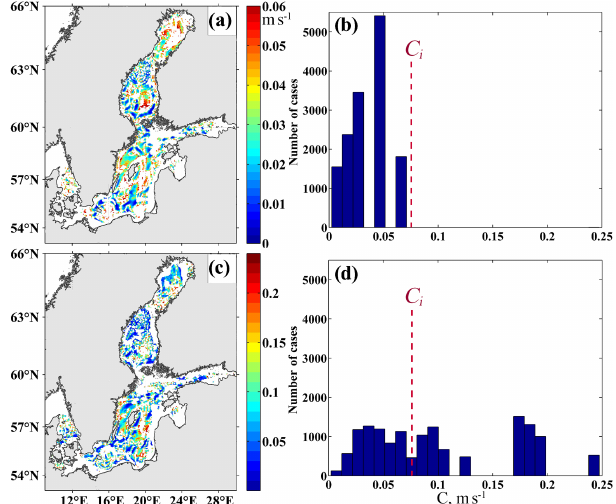
Figure 15. Maps and histograms of phase speed (ms − 1 ) of progressive–standing waves of 385d (a, b) and 89d (c, d) periods. In the regions coloured in white, the estimated phase speed is equal to zero. The dashed line on the histogram plots indicates minimum value of theoretical phase speed of baroclinic gravity